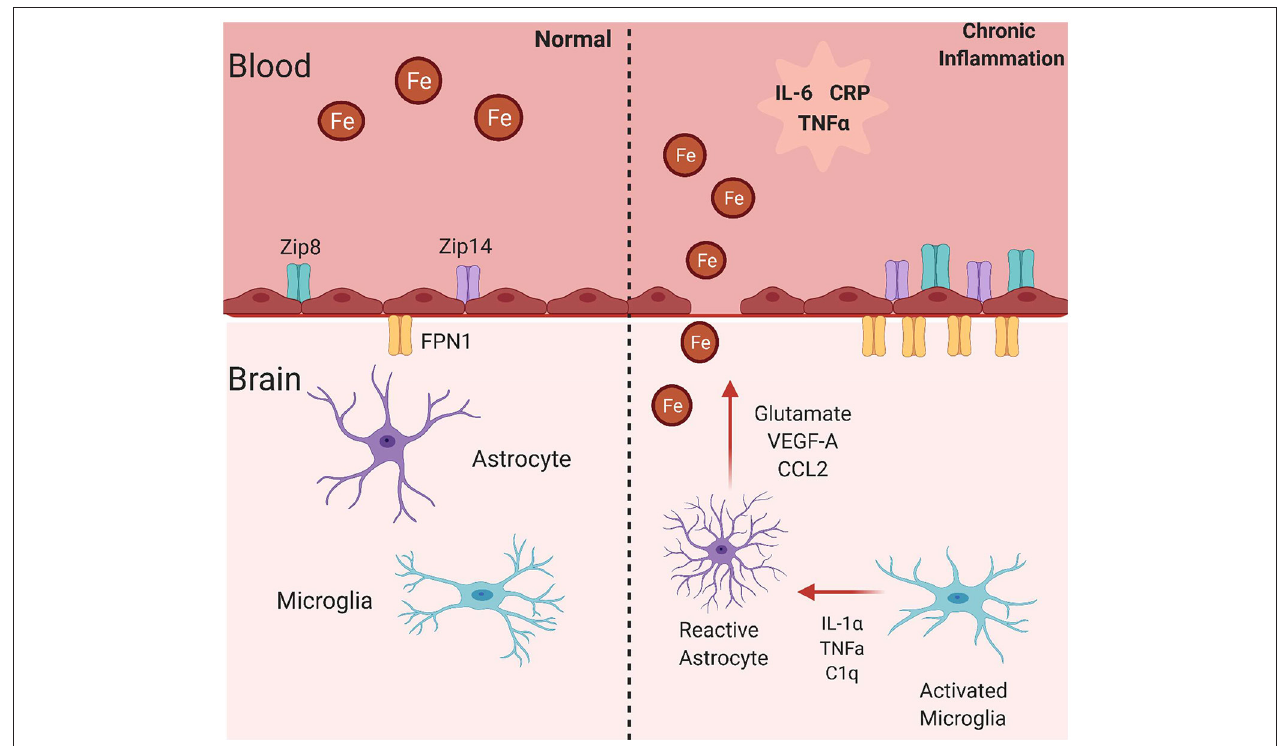
FIGURE 3 | Mechanisms for brain iron accumulation in a state of chronic inflammation. In a state of chronic inflammation, systemic inflammatory factors increase plasma membrane iron transporter occupancy. These include the ferrous iron uptake transporters, ZIP8 and ZIP14, and the sole iron efflux transporter Fpn. Note that these changes occur at both the apical (blood) and basolateral (brain) side of the endothelial cell blood-brain barrier in response to systemic and abluminal signals. This image was created with Biorender.com.